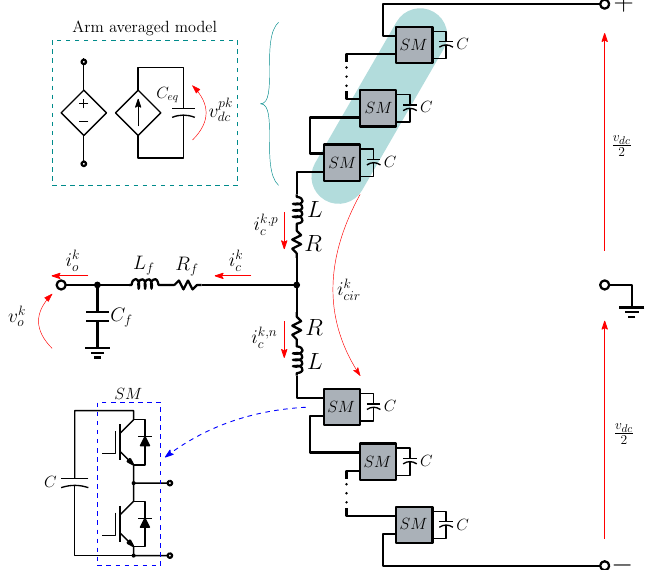
Figure 1. Block diagram of the Modular Multilevel Converter